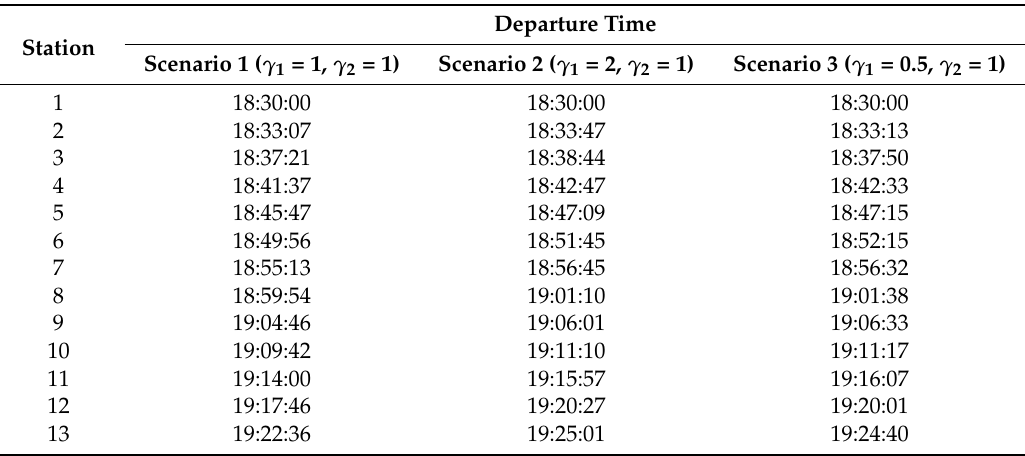
Table 7. The generated robust timetable based on passengers activity information. Unit: